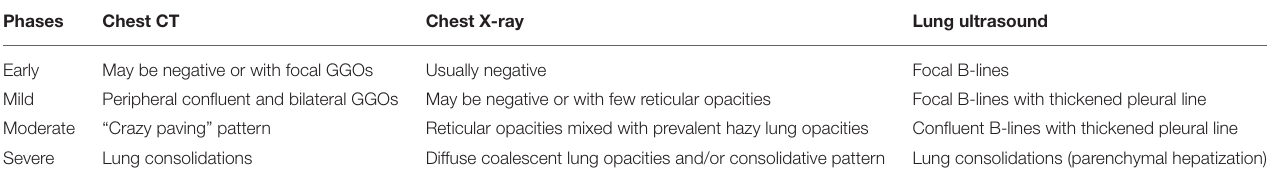
TABLE 1 | Comparison between findings of different stages of COVID-19 pneumonia on Chest X-ray, CT scan, and LUS.